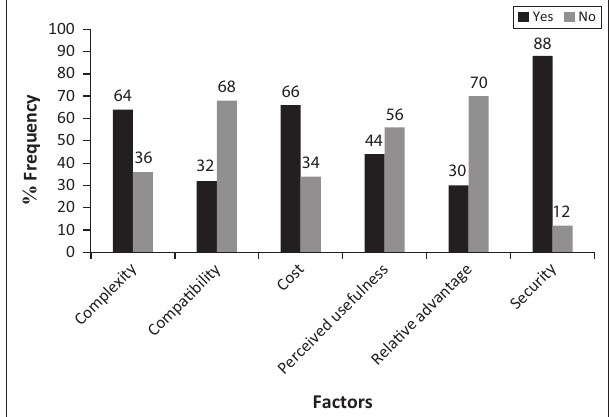
FIGURE 5: Articles by the framework. FIGURE 6: Frequency of technology